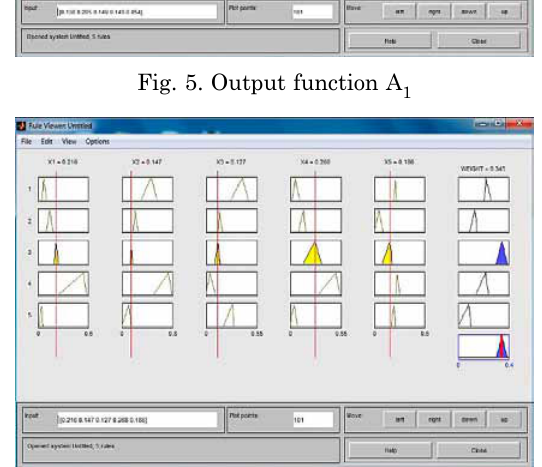
fig. 6. output function a